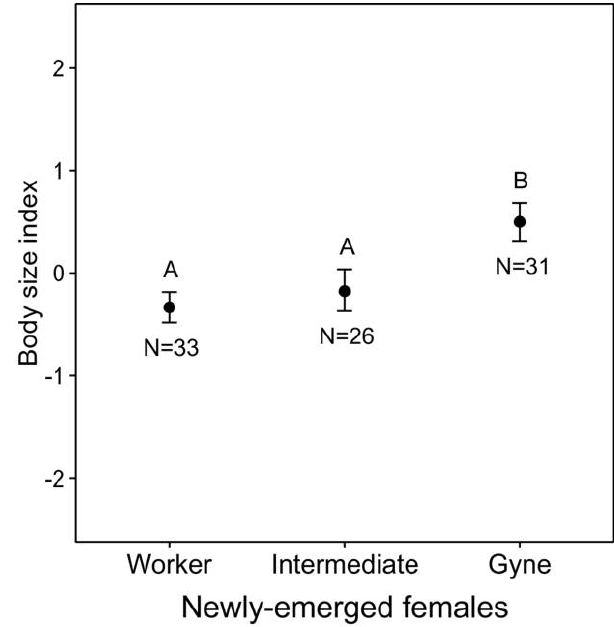
Fig 4. Variation in body size index (mean ± SD) for newly-emerged females in colonies of Mischocyttarus consimilis . Different letters indicate statistical significance ( P